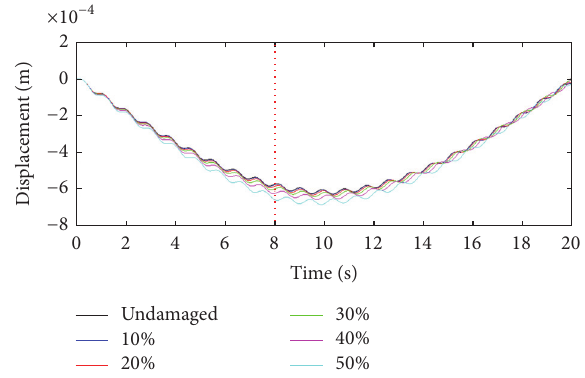
Figure 14: Displacement responses of different damage levels with the mass which is 50 Kg.